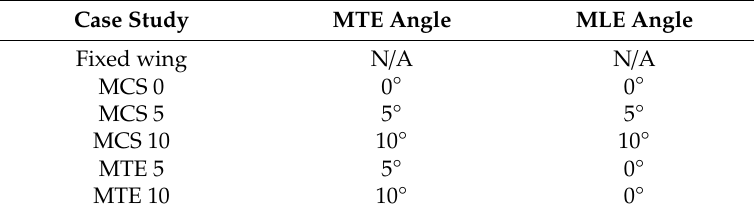
Table 4. Morphing cases studied in wind tunnel.